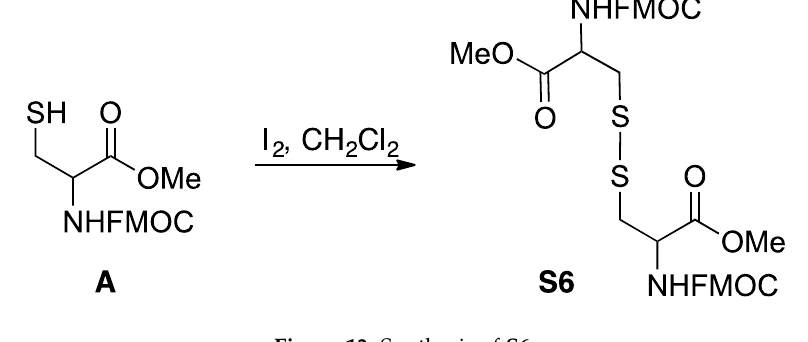
Figure 13. Synthesis of S6 Figure 11. Synthesis of S6 .